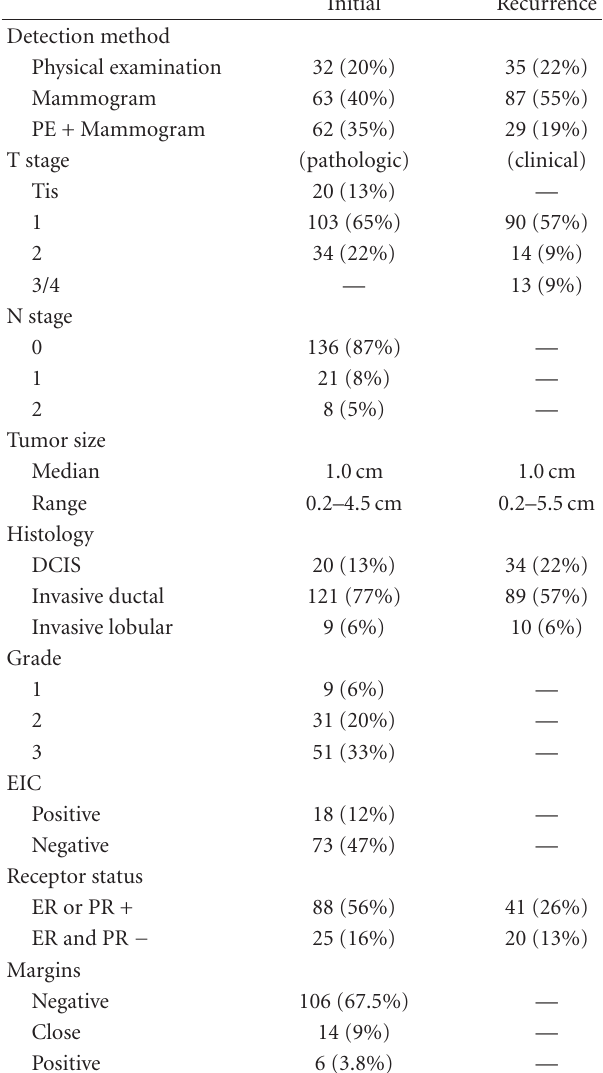
Table 2: Characteristics of 157 local recurrences after whole-breast irradiation.